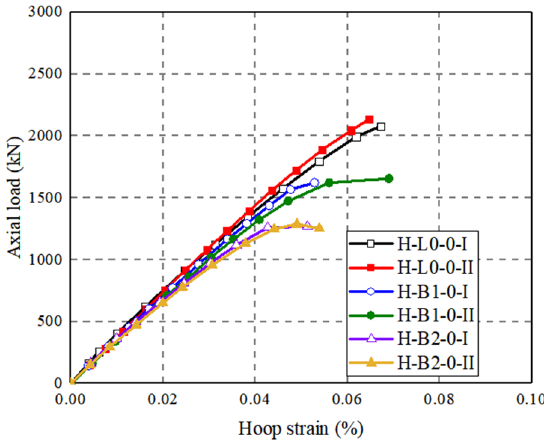
Figure 15. Effect of number of FRP grid layers on axial load–hoop strain curves of FRP grid-UHPC tubular columns.